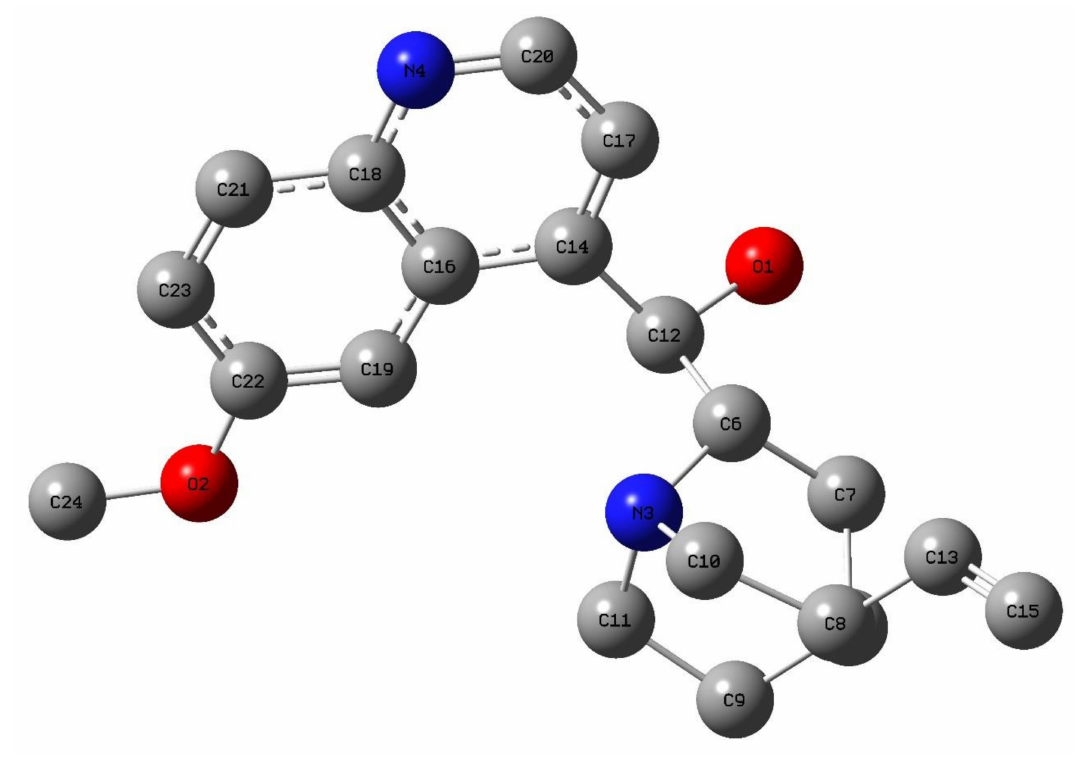
Figure 7. Optimized geometry of Quinine.